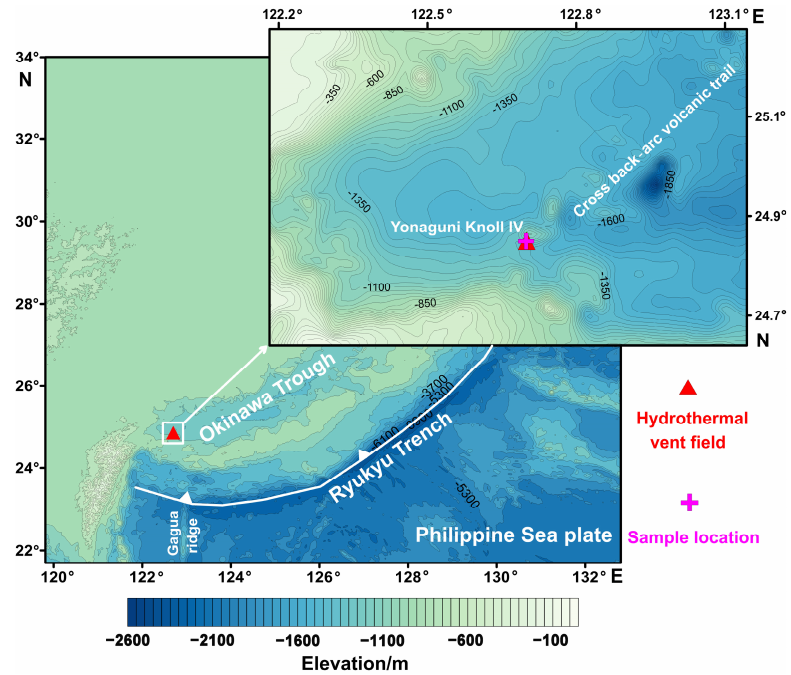
Figure 1. Regional and local bathymetric map showing the location of the studied rhyolite collected in the Yonaguni Knoll IV hydrothermal vent field of the southwestern Okinawa Trough. The Yonaguni Knoll IV hydrothermal field (24 ◦ 51 (cid:48) N, 122 ◦ 42 (cid:48) E) is situated in an elon- gated valley within the CBVT zone [36,42]. Hydrothermal mineralization at the